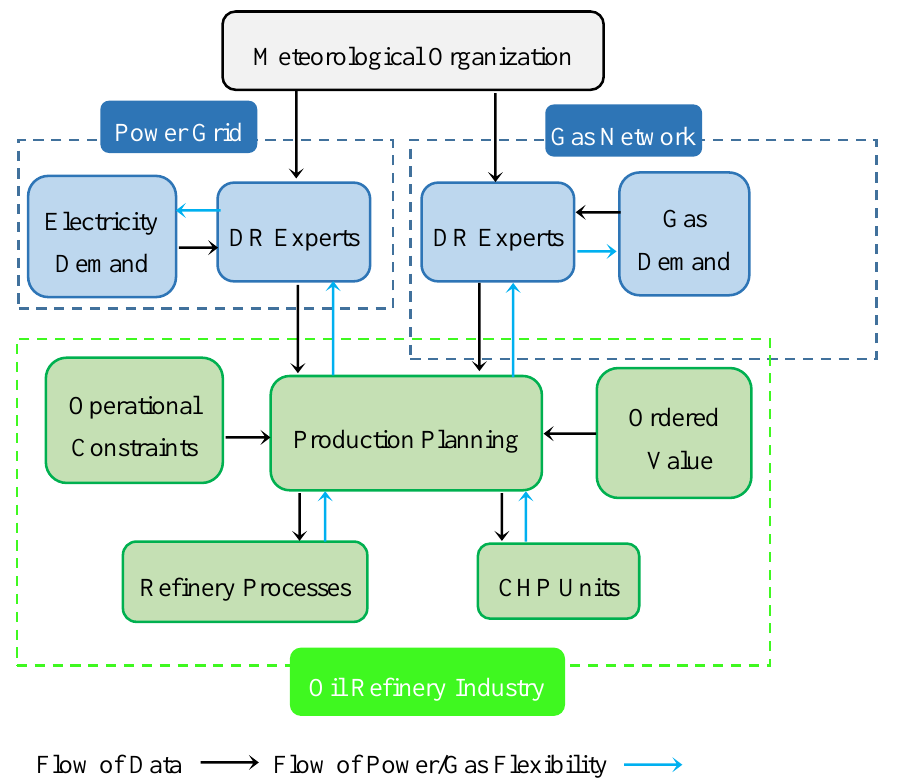
Figure 6. Coordination between different entities to provide demand flexibility for external grids.